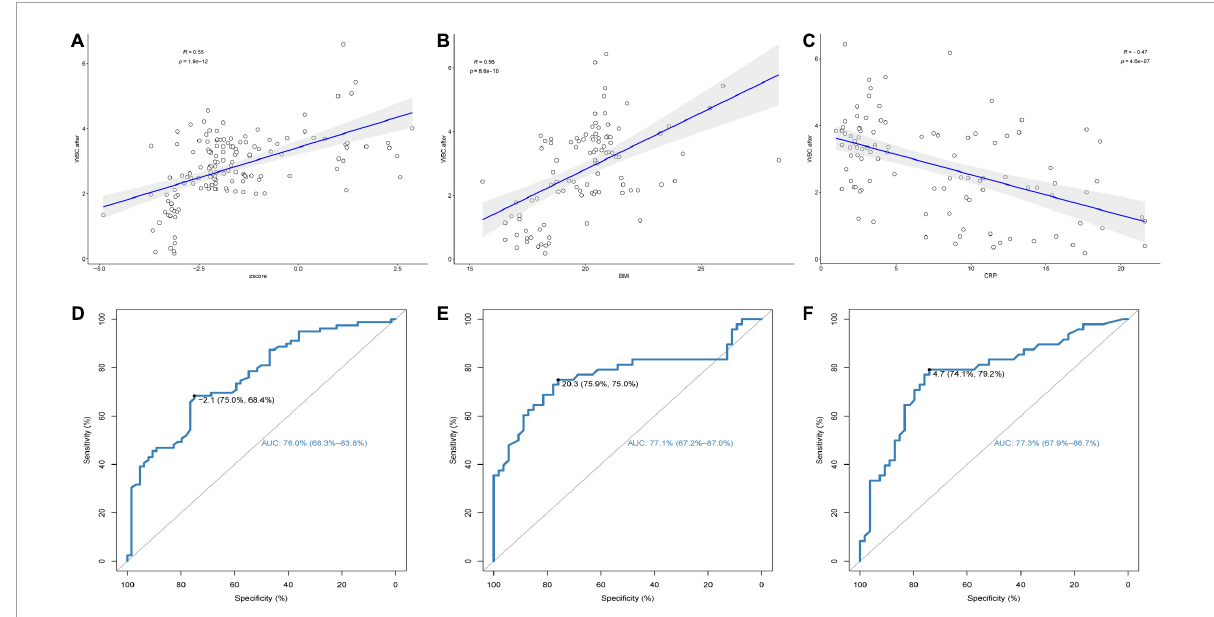
FIGURE2 (1) The correlation between (A) Z -score of adolescents, (B) body mass index (BMI) of adults, (C) C-reactive protein (CRP) of adults, and white blood cell (WBC) levels after chemotherapy. (2) Receiver-operating characteristics (ROC) curves identifying discrimination thresholds of (D) Z -score of adolescents, (E) body mass index (BMI) of adults, (F) C-reactive protein (CRP) of adults for Leucopenia